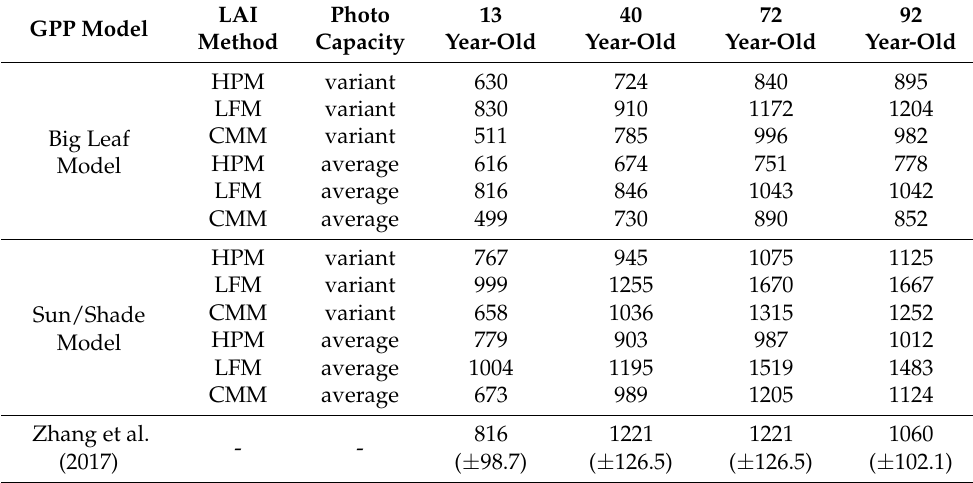
Figure 4. Annual GPP estimation with time since last stand-replacing fire based on different model setups. Big Leaf model with average A sat and K m , (BLa)—red line, Big Leaf with variation of A sat and K m (BLv)—green line, Sun/Shade model with average A sat and K m , (SSa)—blue line, and Sun/Shade model with variation of A sat and K m (SSv)—purple line for all three methods of LAI estimation, ceptometer method (CMM), hemispherical photography method (HPM) and litterfall method (LFM). Big dots represent plot-specific simulations, and dotted lines represent a generic trend with age. Table 5. Annual GPP (g C m − 2 year − 1 ) computed from the sum of simulated daily GPP for the period of 07/2019 to 06/2020. For each site, the estimated long-term (2000–2016) GPP ( ± one SD) from an independent dataset [66] is also provided as a baseline. For the 40 year-old and the 72 year-old plots the independent dataset provided the same GPP, as these two plots are within a 500 m